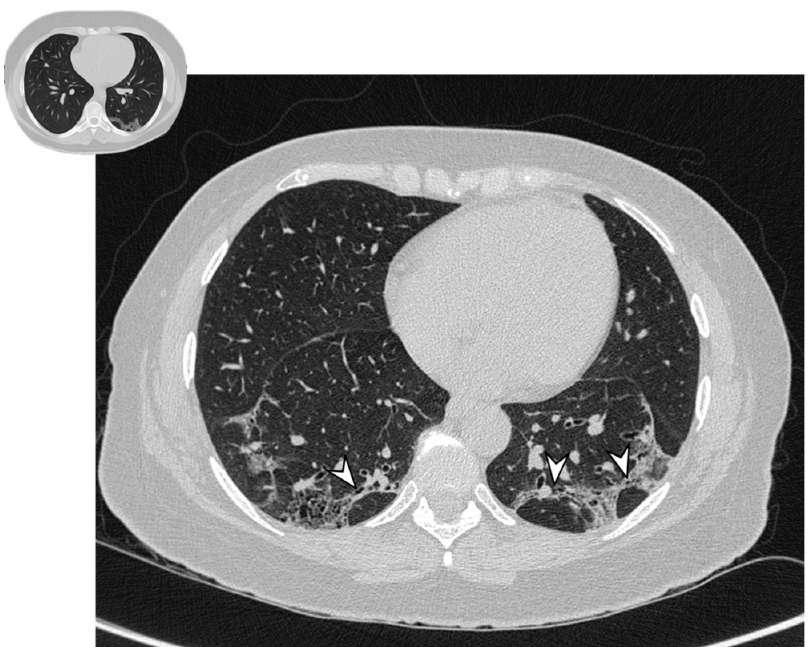
Figure 6. Perilobular pattern: arcade-like bands of parenchymal consolidation (white arrowheads) with blurred borders and thickening of the interlobular septa with a reticular pattern.